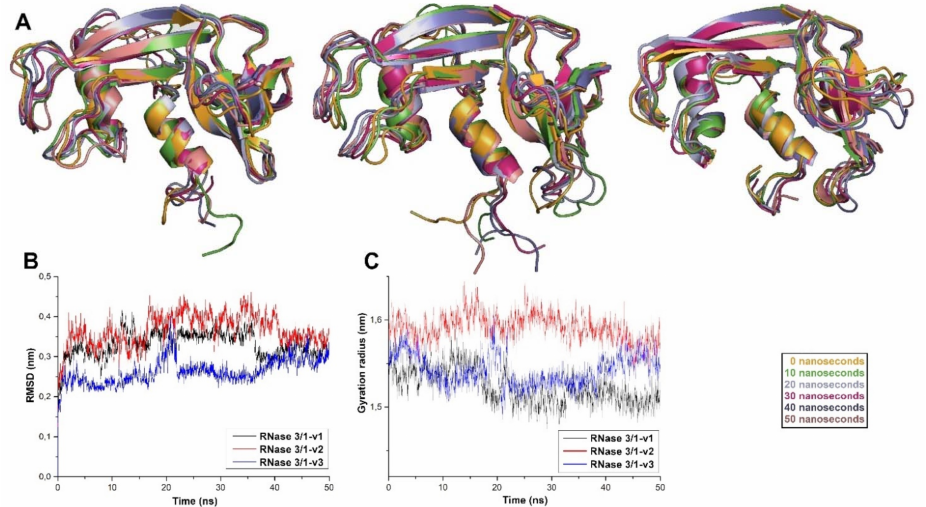
Figure 2. ( A ) Overlapping of the three versions of RNase 3/1 after 50 nanoseconds of molecular dynamics. ( B ) RMSD variation for the three hybrid RNases. ( C ) Gyration radius of the structure of hybrid RNases against